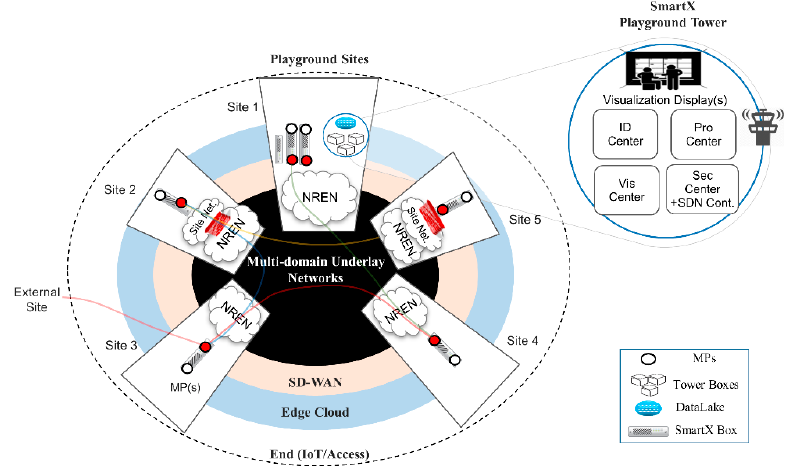
Figure 1. OF@TEIN playground as a software-defined networking (SDN)-enabled multisite cloud.